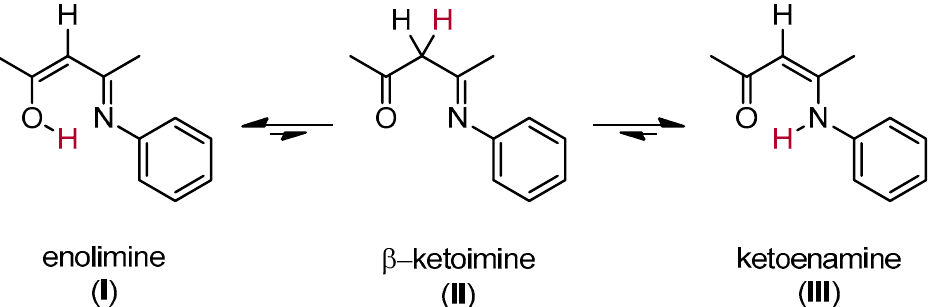
Figure 2. ATR ‐ IR ( a ) and Far ‐ IR ( b ) spectra of complexes 1 (green line) and 2 (red line) in comparison to that of the ligand L (grey line)in the most relevant spectroscopic regions. Measurements were performed on complexes in the solid state.